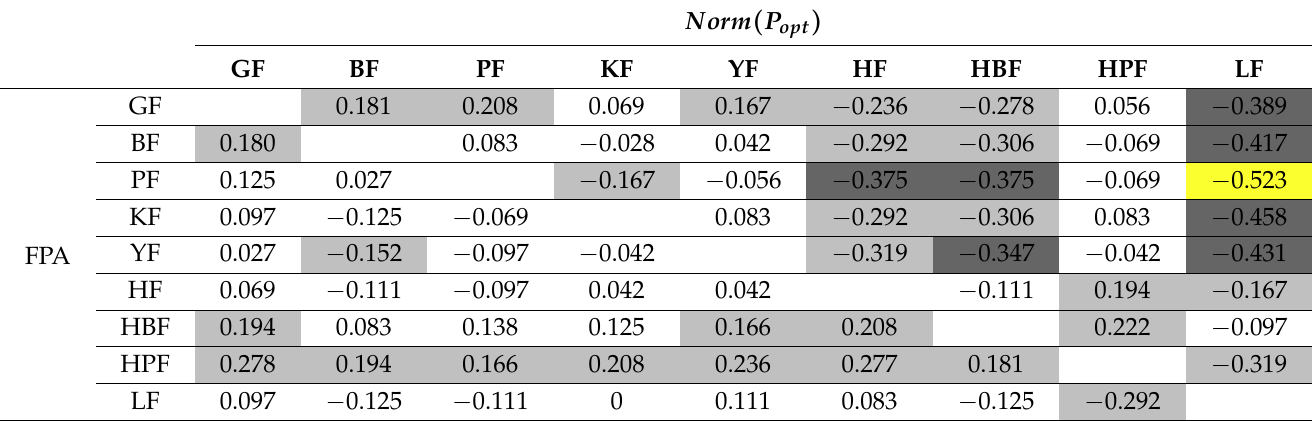
Table 3. Cliff’s δ of the Nine Training Data Selection Methods in Terms of FPA and Norm ( P opt ) .